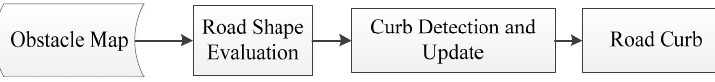
Figure 11. Road curb extraction diagram.